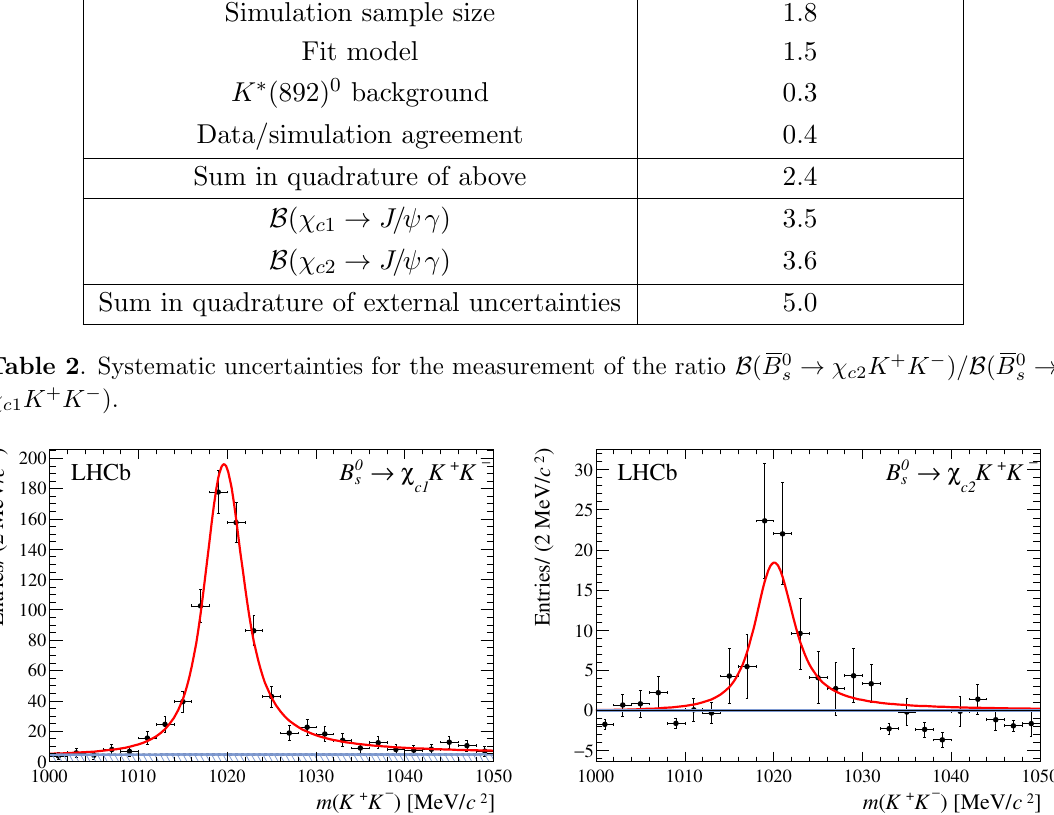
Figure 5 . Invariant-mass distribution of the K + K obtained with the (cid:31) c 1 mass constraint applied to the B 0 + K ! (cid:31) B 0 (cid:0) decay obtained with the (cid:31) c 2 mass constraint applied to the B c 2 K s mass. The (red solid line) total (cid:12)tted function is superimposed together with (blue hashed area) the S-wave